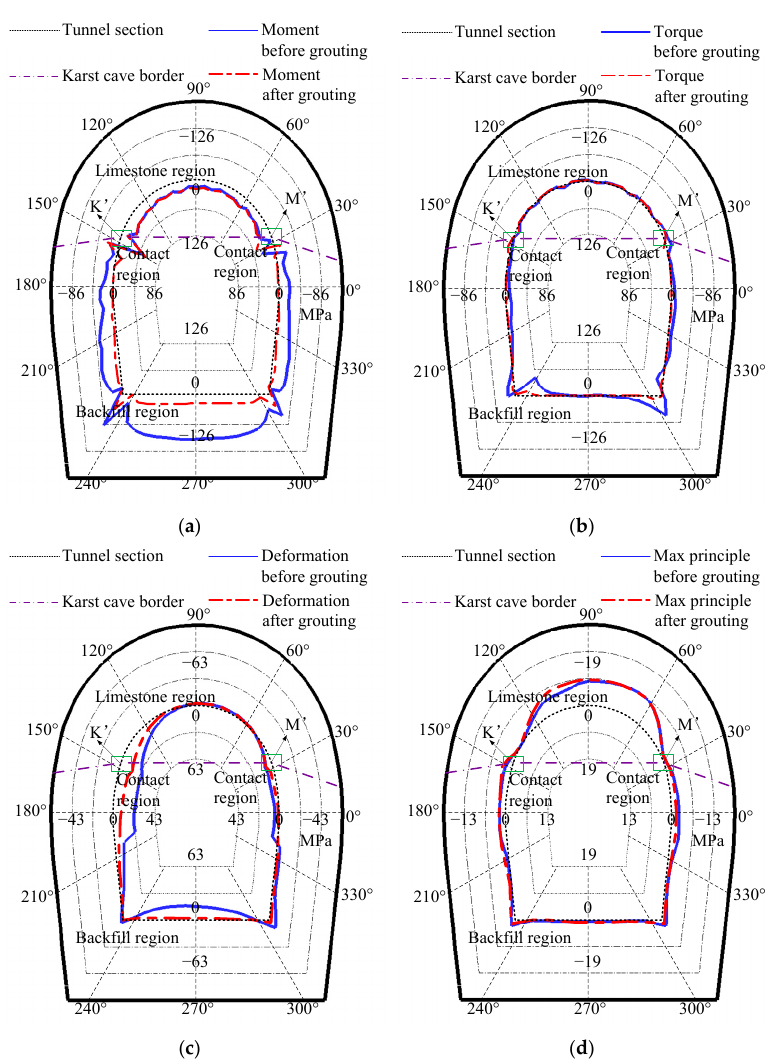
Figure 10. Mechanical response of II-type tunnel on Y = 10 m section ( a ) bending moment ( b ) torque ( c ) deformation and ( d ) max principle of support.